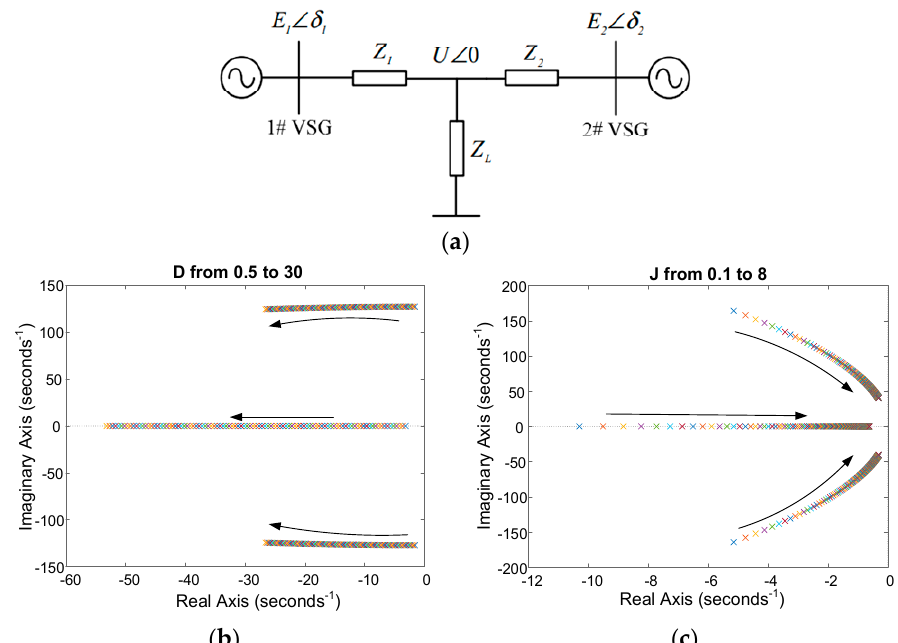
Figure 2. Small-signal stability analysis results of two VSGs operating in parallel. ( a ) The network of two VSG system, ( b ) The eigenvalues of system as the inertia varies, ( c ) The eigenvalues of system as the damping varies.